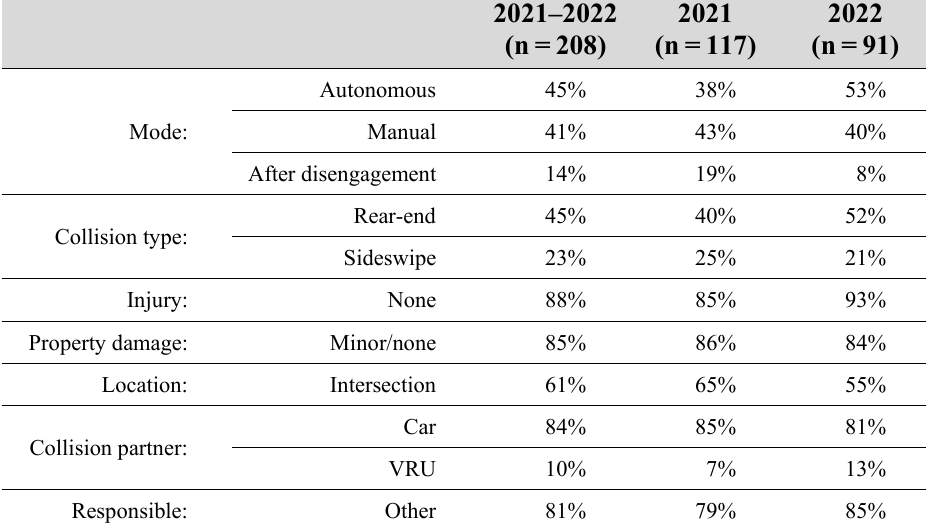
Table 2 Comparison of collisions’ characteristics between 2021 and first half of